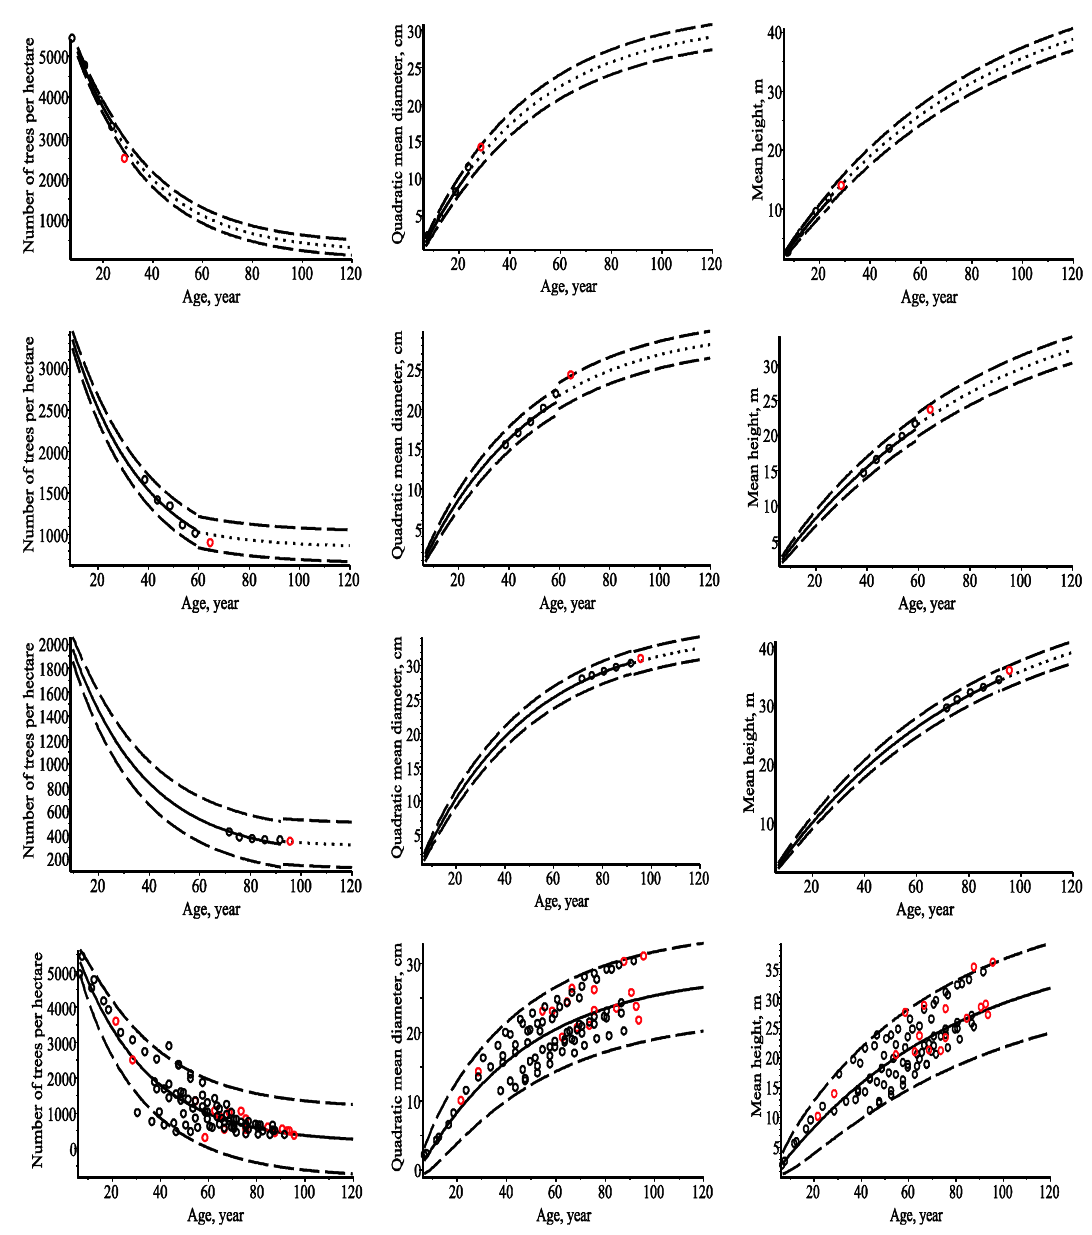
Figure 5. Mean of response variable dynamics and mean ± 2 standard deviations with observed data points. Mean response variable prediction trend from initial age to observed stand age—solid line and forecast trend from this age forward—dot line, for three randomly selected stands (from first till third row). First row—mixed e ff ects scenario for the first stand; second row—mixed e ff ects scenario for the second stand; third row—mixed e ff ects scenario for the third stand; last row—fixed e ff ects scenario for all stands; mean ± 2 standard deviations—dash; estimation dataset—black circles, validation dataset—red circles . Table 2. Statistical indexes and p -values of the Shapiro-Wilk (SW p ) and Student (T p ) tests for the mixed effect scenario models*.